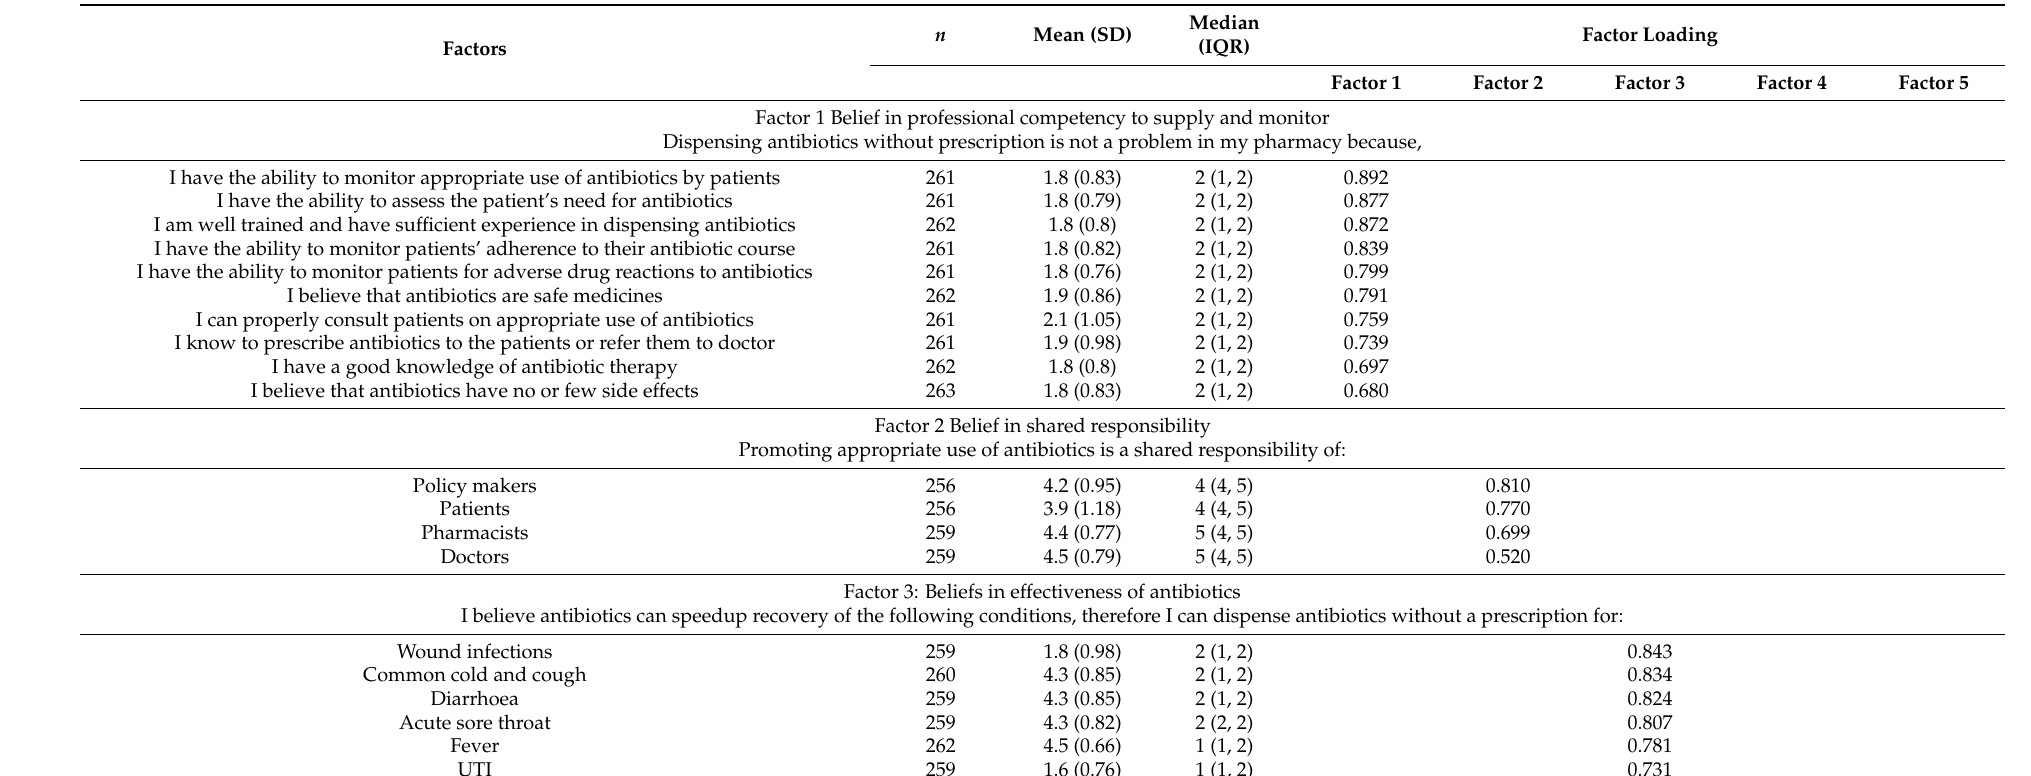
Table 2. Exploratory factor